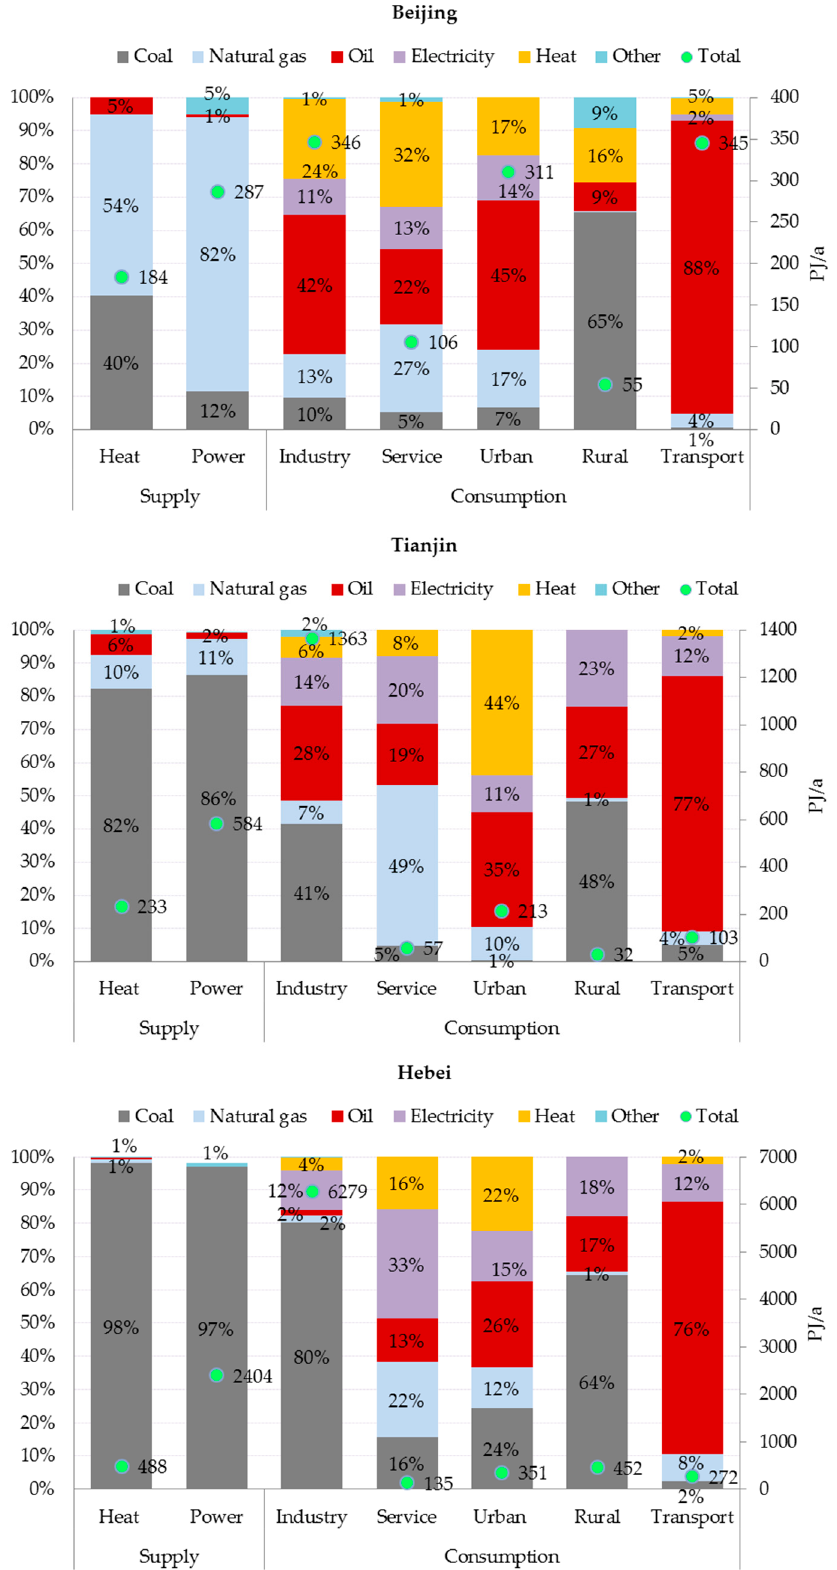
Figure A1. Heat and power energy supply and final energy consumption in BTH region in 2015 by sector [17].